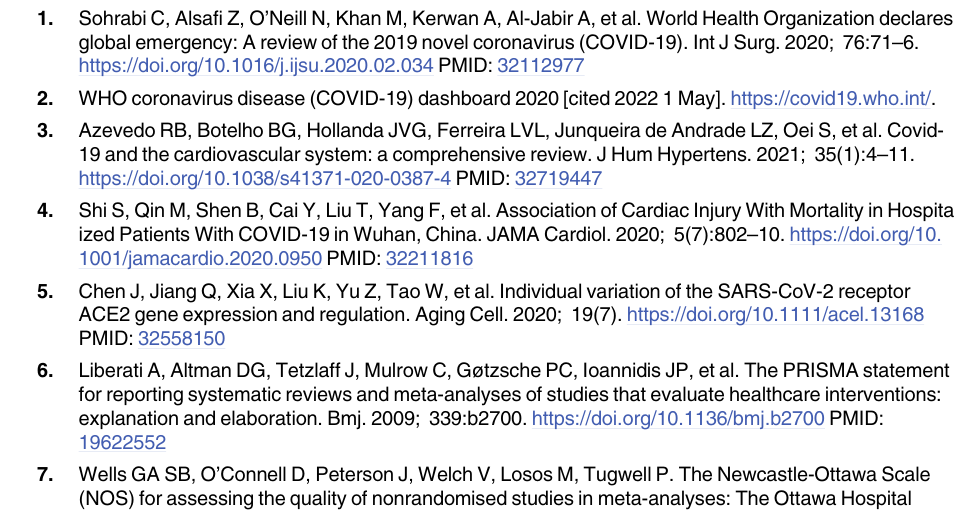
S1 Table. Clinical outcomes of East-Asian Covid-19 patients treated with ACEI/ARB vs. untreated subjects (CVDs